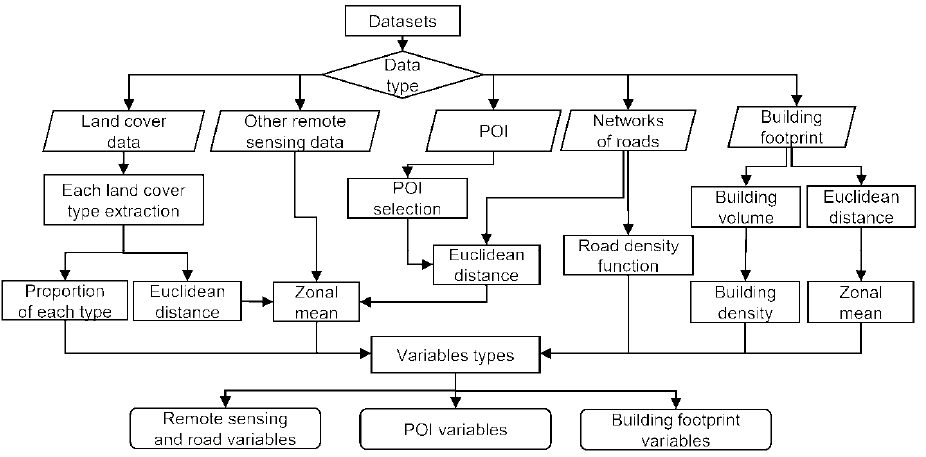
Figure 2. Flowchart of the data preparation process.